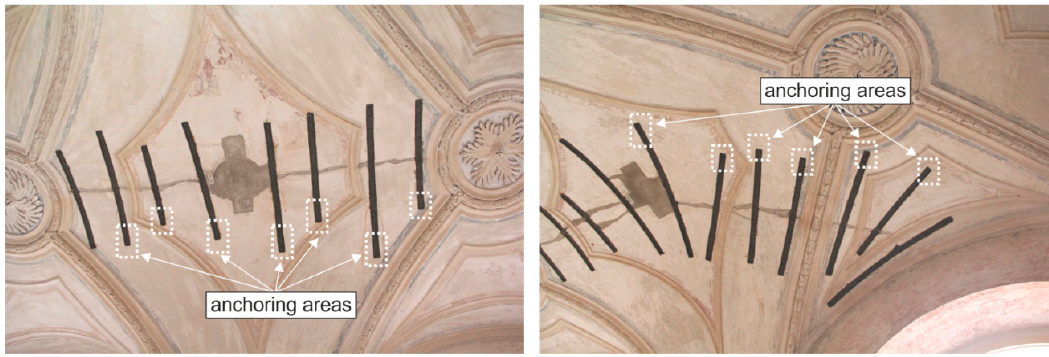
Figure 14. Alternation of anchoring areas of neighboring carbon composite strips.